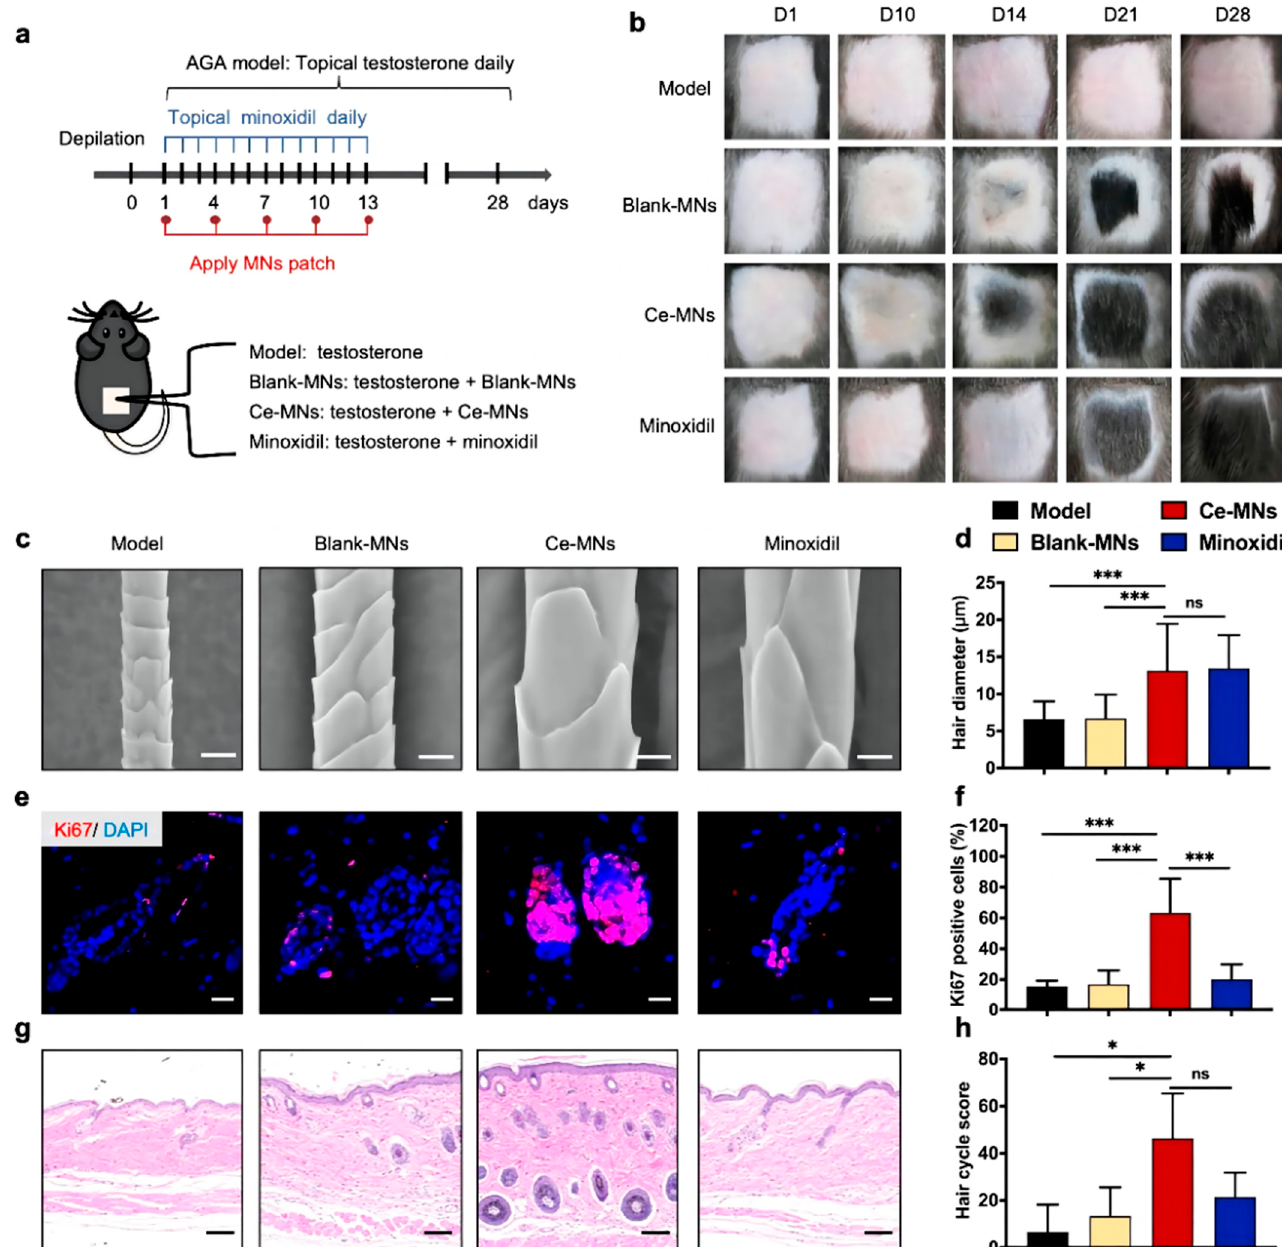
Figure 6. In vivo AGA treatment efficiency of the Ce-MN system. ( a ) Schematic representation showing the establishment of the AGA mouse model via the topical application of a testosterone solution daily for 28 days and the therapeutic strategies in the established model. ( b ) Representative photographs of mouse hair regrowth status in the model, Blank MN, Ce-MNs, and minoxidil groups. ( c ) SEM images of regenerated hair at day 28 post-depilation. Scale bar = 10 µm. ( d ) Diameter of regenerated hair at day 28 post-depilation. ( e ) Representative images of Ki67 expression in skin tissues from di ff erent groups at day 10 post-depilation. Scale bar = 20 µm. ( f ) Quantitative anal- ysis of Ki67-positive cells at day 10 post-depilation. ( g ) Hematoxylin-eosin (H&E) staining of the treated skin at day 10 post-depilation. Scale bar = 100 µm. ( h ) Hair cycle score at day 10 post-depi- lation. All results are presented as the mean ± SD. ns, nonsigni fi cant ( p > 0.05), * p < 0.05, *** p < 0.001. [70]. Copyright 2021 American Chemical Society.